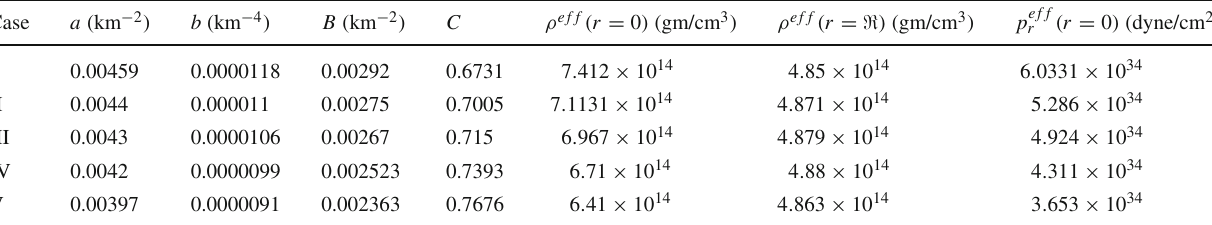
Table 2 Determination of model parameters a , b , C , B , central density, surface density, radial pressure for different strange star